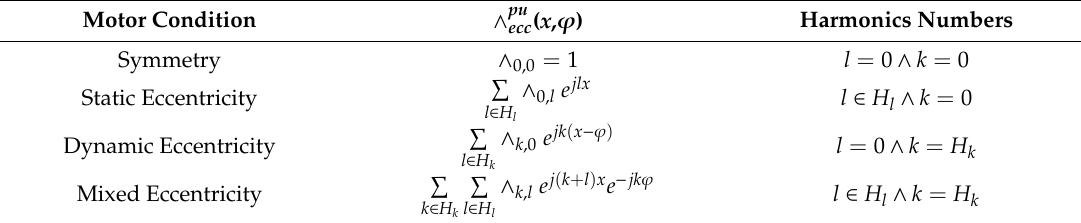
Table 1. Permeance function for di ff erent types of eccentricity